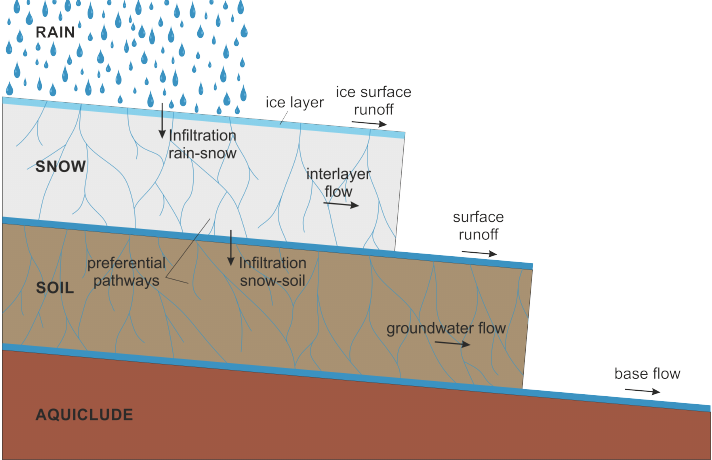
Figure 3. Schematic illustration of the four relevant layers: rain, snowpack with possible ice layer, soil, and aquiclude. Resulting processes from infiltration, melting, runoff, and flow are indicated by arrows. Branched lines in the snow and soil layer show preferential